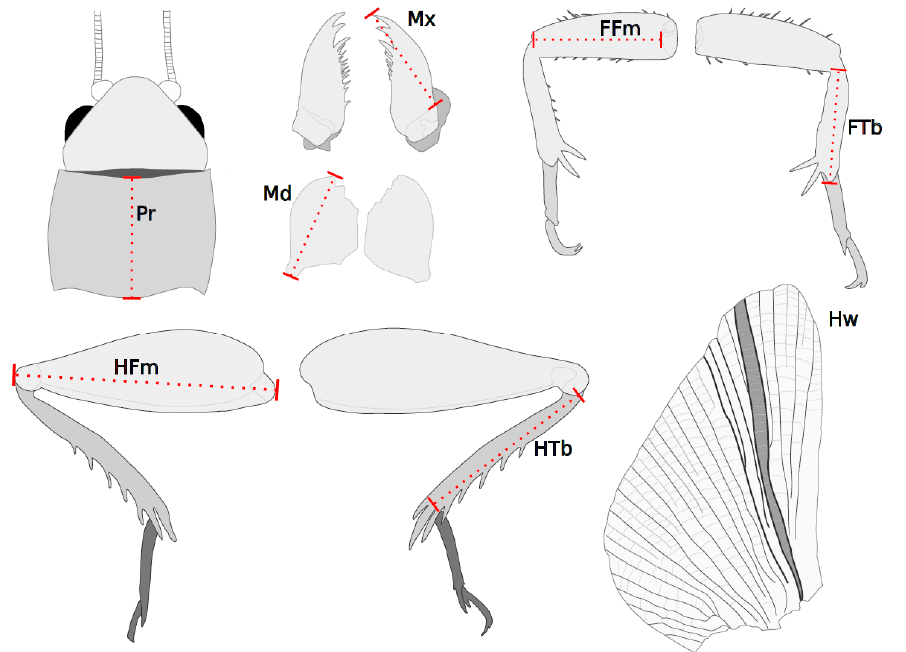
Figure 1. A diagram of the eight linear measurements recorded for each cricket. Illustrations depict the orientation of images from which measurements were collected: dorsal view of the head where Pr is the pronotum; ventral view of the left and right mouthparts where Mx is the maxilla and Md is the mandible; medial view of the forelimbs where FFm is the front femur and FTb is the front tibia; lateral view of the hindlimbs where HFm is the hind femur and HTb is the hind tibia; and dorsal view of a hindwing (Hw). Morphological measurements for each structure are shown as dotted lines. Drawings are not to the same scale.